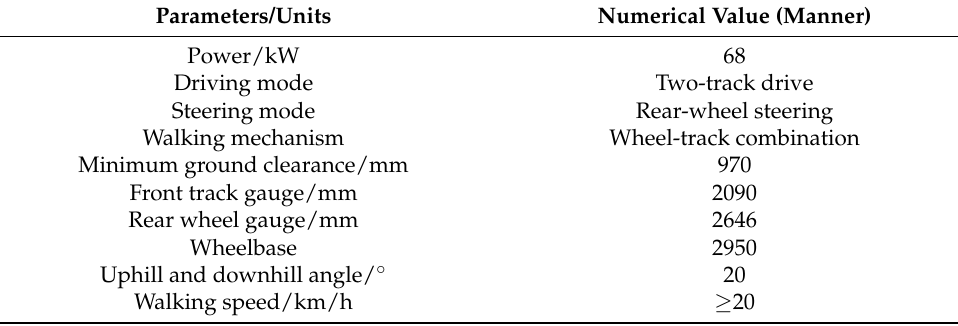
Table 1. Main technical parameters of the wheel-track high clearance chassis.